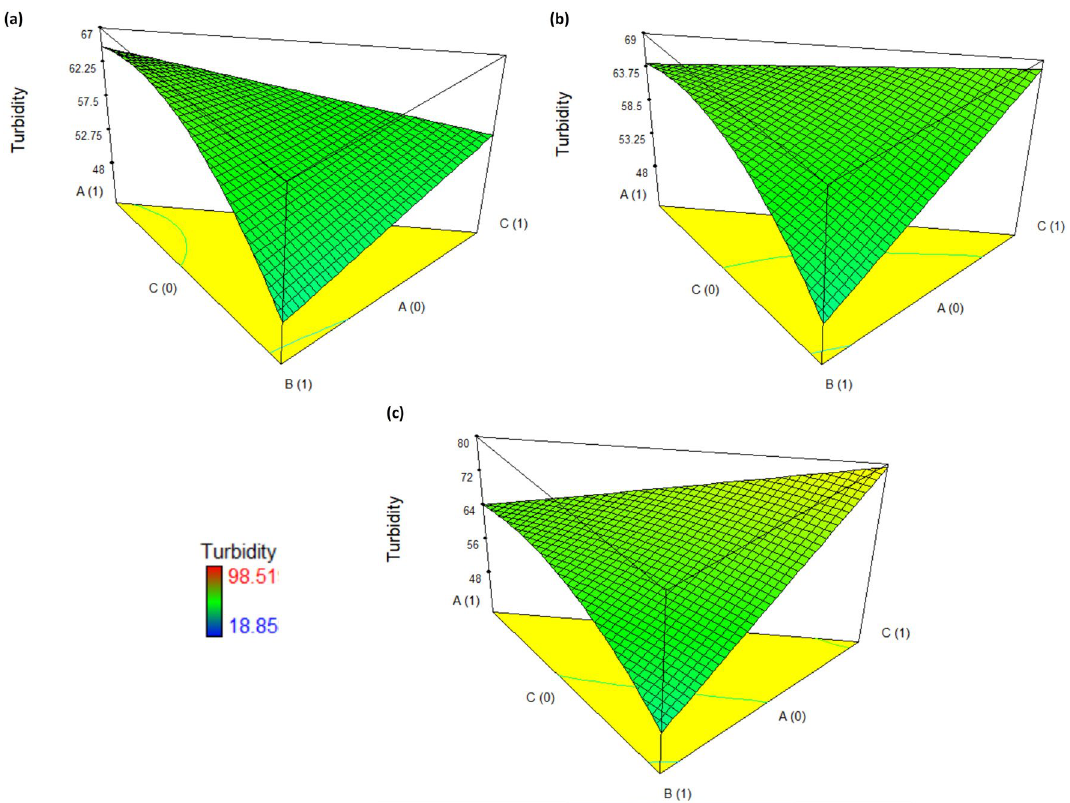
Figure 2. 3D response surface plots for the turbidity removal in ceramic industry wastewater using coagulant doses: ( a ) low-200 mg/L, ( b ) medium-500 mg/L, and ( c ) high-800